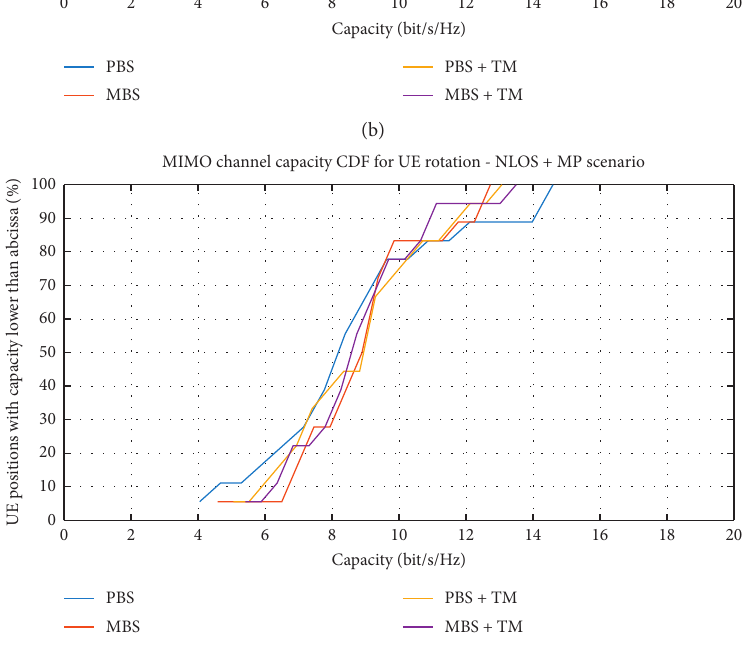
Figure 23: Capacity CDF according to the UE positions for PBS, MBS, PBS+hand grip, and MBS+hand grip (TM: Talk Mode hand grip): (a) LOS; (b) LOS+ multipath; (c) NLOS